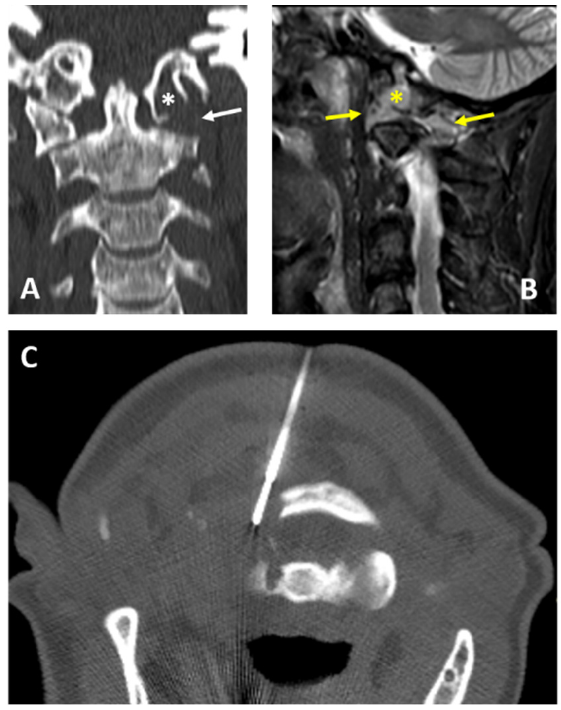
Figure 1. A 52-year-old woman: CT frontal view ( A ); MRI T2w fat sat sagittal view ( B ) show osteolytic lesion involving the left condyle of the occiput (white and yellow asterisks) and both the anterior and posterior arch of the atlas (white and yellow arrows). CT-guided biopsy ( C ) was performed with a posterior approach using a 14G needle (Bonopty). The final histopathological diagnosis on the biopsy specimen was multiple myeloma.